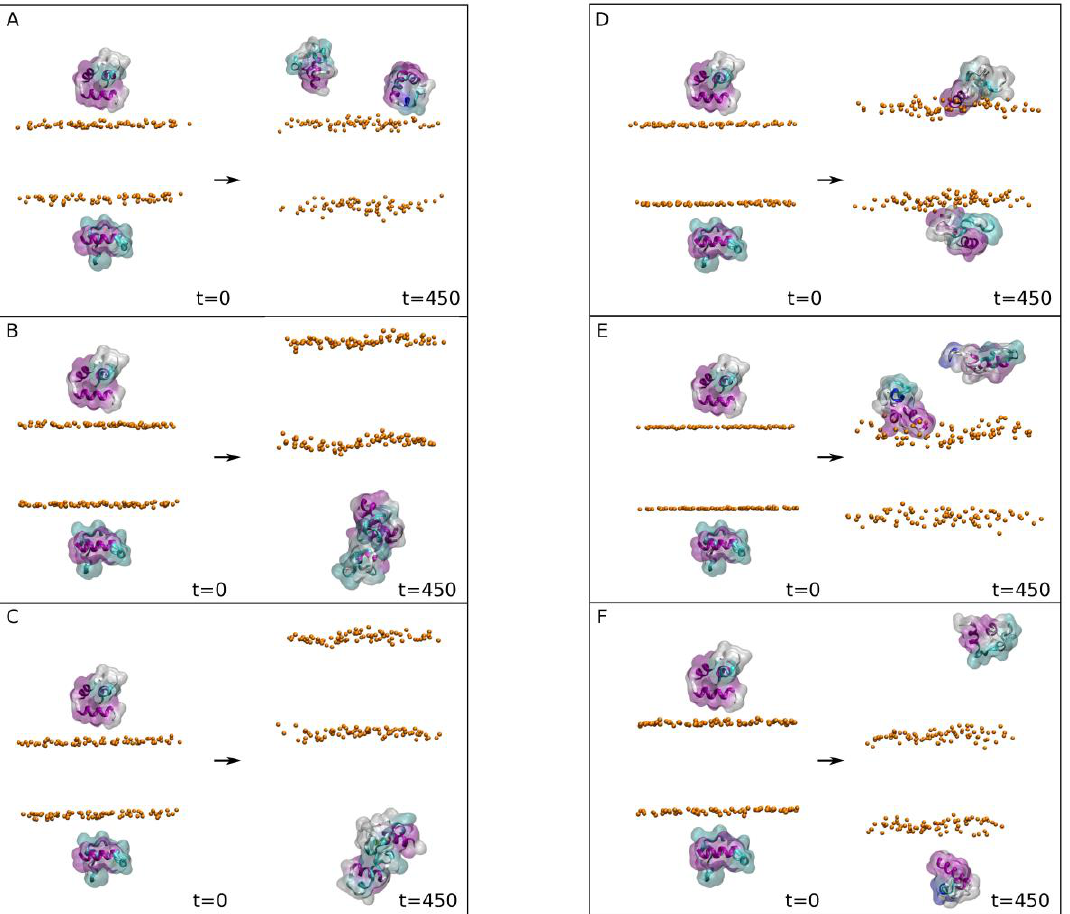
Figure 2. Initial (left) and final (right) arrangements corresponding to the second step (systems 2-1 to 2-6) for systems containing ( A ) POPC/CHOL, ( B ) POPE/CHOL, ( C ) POPS/CHOL, ( D ) PI-3P/CHOL, ( E ) BMGP/CHOL and ( F ) PSM/CHOL in the presence of 0.15 M NaCl (MD time 450 ns). The peptides are shown in both ribbon and surface transparent drawing style with coloured secondary structures (white (coil), violet (helix), yellow (extended), light blue (turns)). The surrounding phospholipid phosphate atoms are shown in VDW drawing style (orange). The water molecules and the chloride and sodium ions have been removed for clarity.